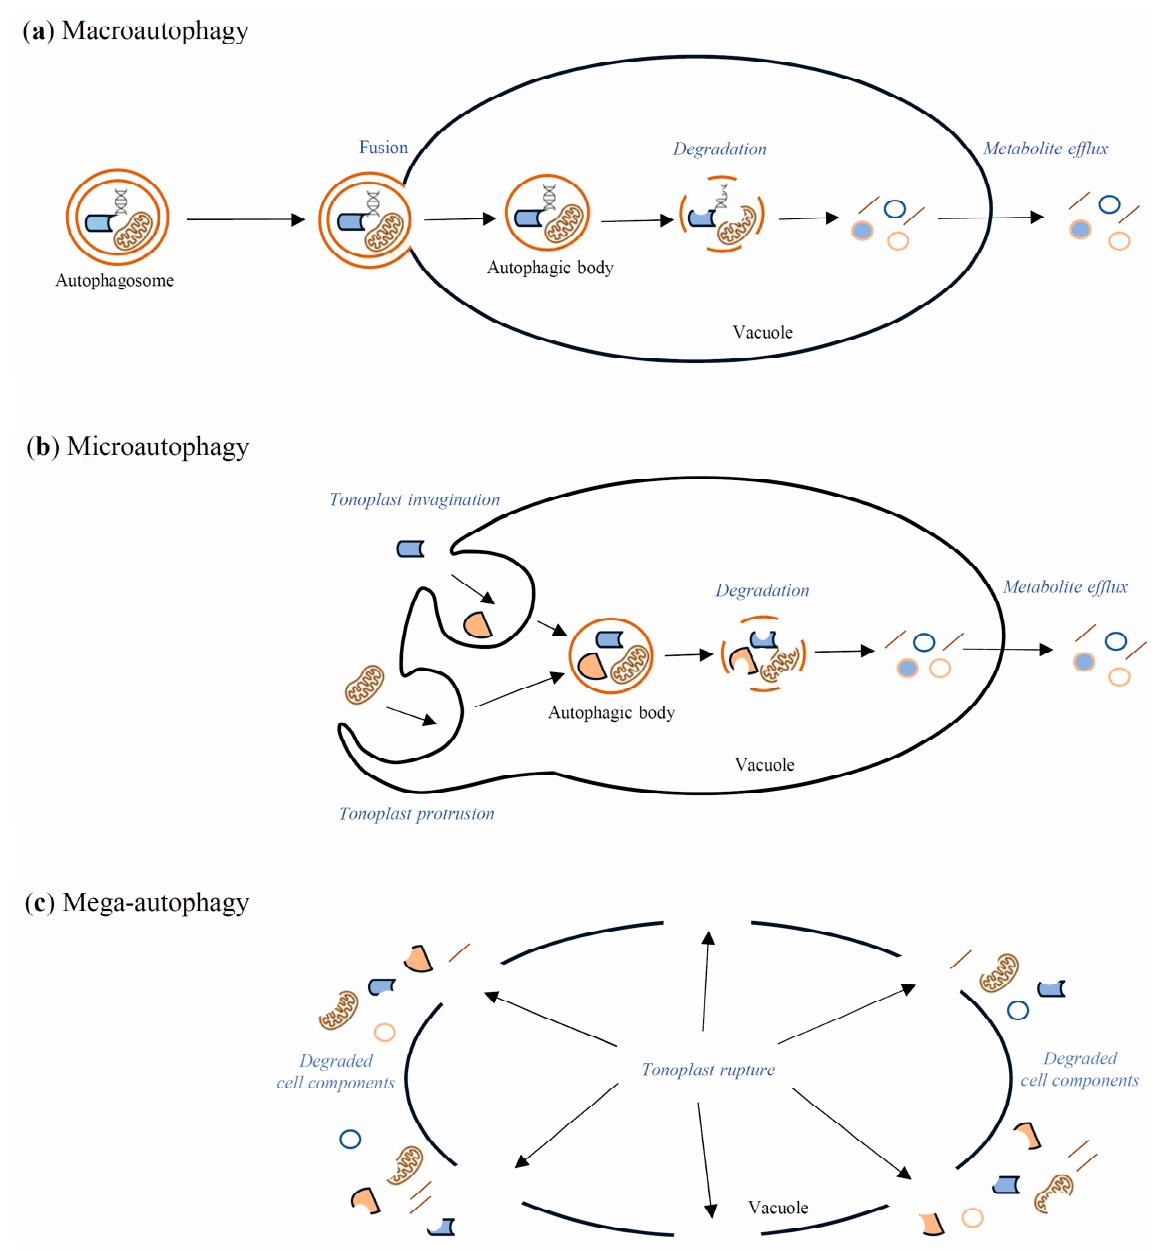
Figure 1. Schematic diagram of macroautophagy ( a ), microautophagy ( b ), and mega-autophagy ( c ) in plants. During macroautophagy, cargo intended for degradation is transported to the vacuole inside an autophagosome. The outer membrane of the autophagosome fuses with the tonoplast, while the internal autophagosome membrane and the cargo create an autophagic body inside the vacuole. The autophagic body is rapidly degraded by vacuolar hydrolases, which allow for the recycling of metabolites. During microautophagy, the autophagosome is not formed, but cell components intended for degradation enter the vacuole through the tonoplast invagination or tonoplast protrusion. Inside the vacuole, there arise the autophagic bodies, which, as in macroautophagy, are degraded by vacuolar hydrolases. Mega-autophagy differs significantly from macro- and microautophagy, as cell elements are not transported to the vacuole for degradation. Instead, the vacuole membrane is destroyed, and subsequently cell death